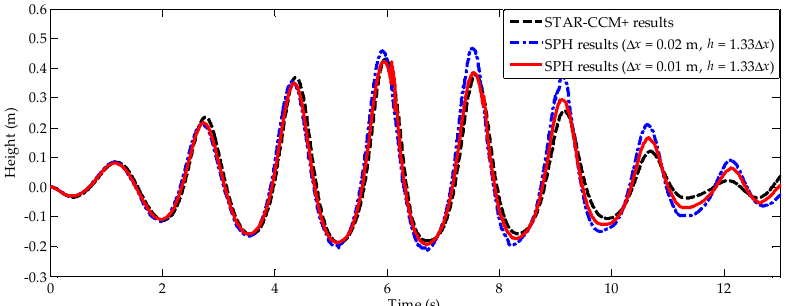
= Δ = Δ for the wave elevation at the for the wave elevation at the